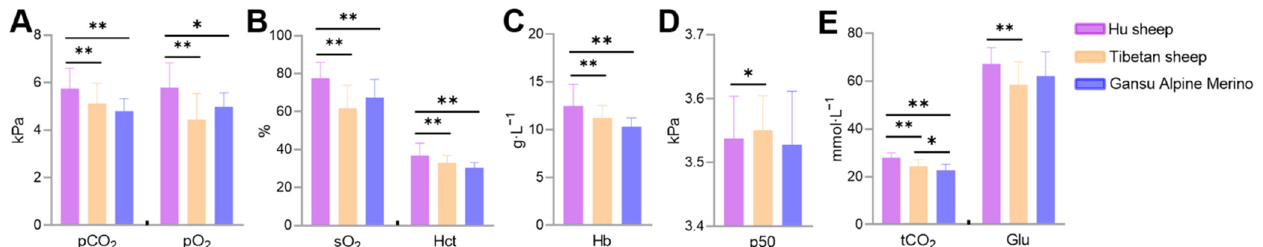
Figure 1. Differences in blood gas indicators between Tibetan sheep, Hu sheep and Gansu alpine merino sheep. Partial pressure of carbon dioxide (pCO 2 ) and partial pressure of oxygen (pO 2 ) ( A ), oxygen saturation (sO 2 ) and hematocrit (Hct) ( B ), hemoglobin (Hb) concentration ( C ), half-satura- tion oxygen partial pressure (p50) ( D ), total carbon dioxide (tCO 2 ) and glucose (Glu) concentration ( E ) are shown. * Indicates significant ( p < 0.05) and ** indicates extremely significant ( p < 0.01) dif- ferenced.